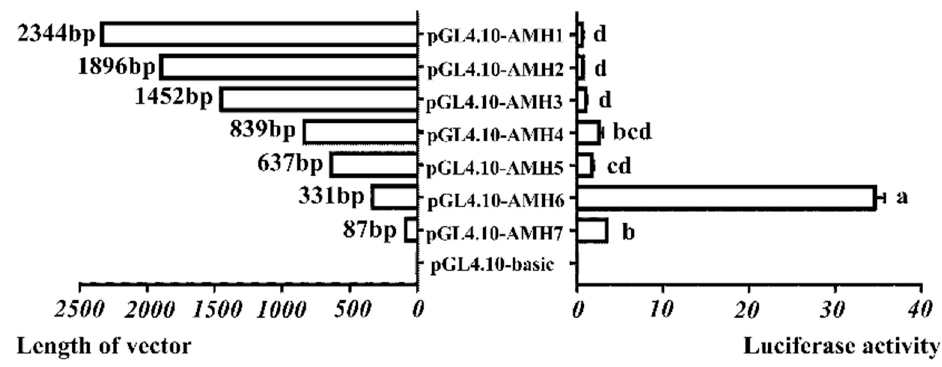
Figure 5. Analysis of AMH gene promoter activity in geese. Luciferase report vectors containing various lengths of the goose AMH promoter region were constructed and transfected into Chinese hamster ovary (CHO) cells. Various lengths of goose AMH region contained pGL4.10-AMH1, deletion of − 2344 to − 1 bp; pGL4.10-AMH2, deletion of − 1896 to − 1 bp; pGL4.10-AMH3, deletion of − 1452 to − 1 bp; pGL4.10-AMH4, deletion of − 839 to − 1 bp; pGL4.10-AMH5, deletion of − 637 to − 1 bp; pGL4.10-AMH6, deletion of − 331 to − 1 bp and pGL4.10-AMH7, deletion of − 87 to − 1 bp. The left bars indicated truncated AMH promoter sequences linked to luciferase, the bars on the right indicated luciferase activity relative to the pGL4.10-basic negative control vector. Each column represented the mean ± SD ( n = 3). Different lowercase letters represented the evident difference ( p < 0.05).